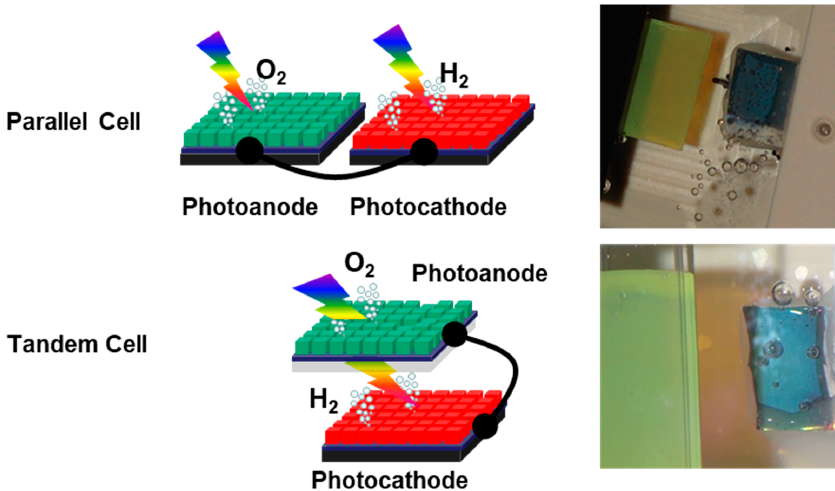
Figure 3. Schematic diagrams of dual ‐ photoelectrode stand ‐ alone overall water photo ‐ splitting devices. In the parallel cell, a pair of photoanode and photocathode is electrically shunted